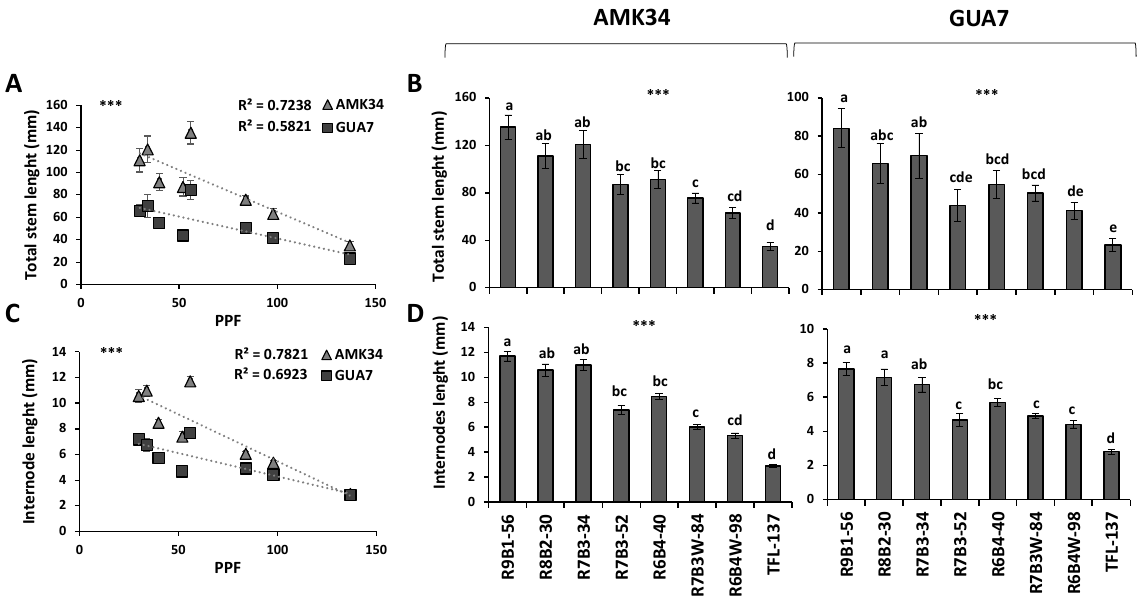
Figure 2 . Effect of light quality and quantity on stem length and internodal elongation of micropropagated olive plantlets. Effect of different illumination regimes from light-emitting diodes (LEDs) and fluorescent lighting (TFL-137) on total stem length ( A , B ) and average internodal length ( C , D ) of different Olea europaea subspecies: subsp. europaea (genotype AMK34); and subsp. guanchica (genotype GUA7). PPF, photosynthetic photon flux. Level of significance: *** p ≤ 0.001.